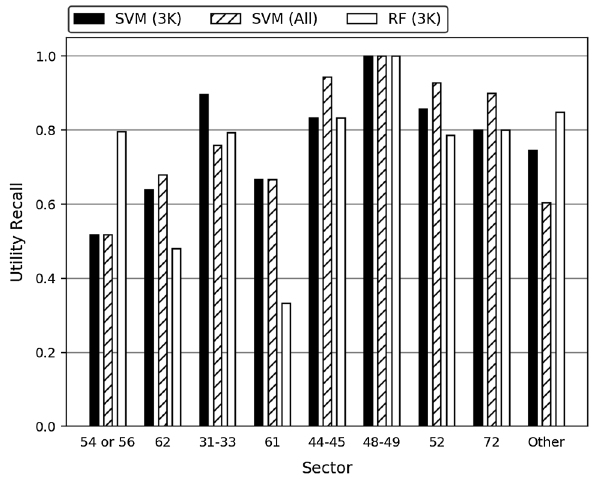
Fig. 5 Error rate per industry in test